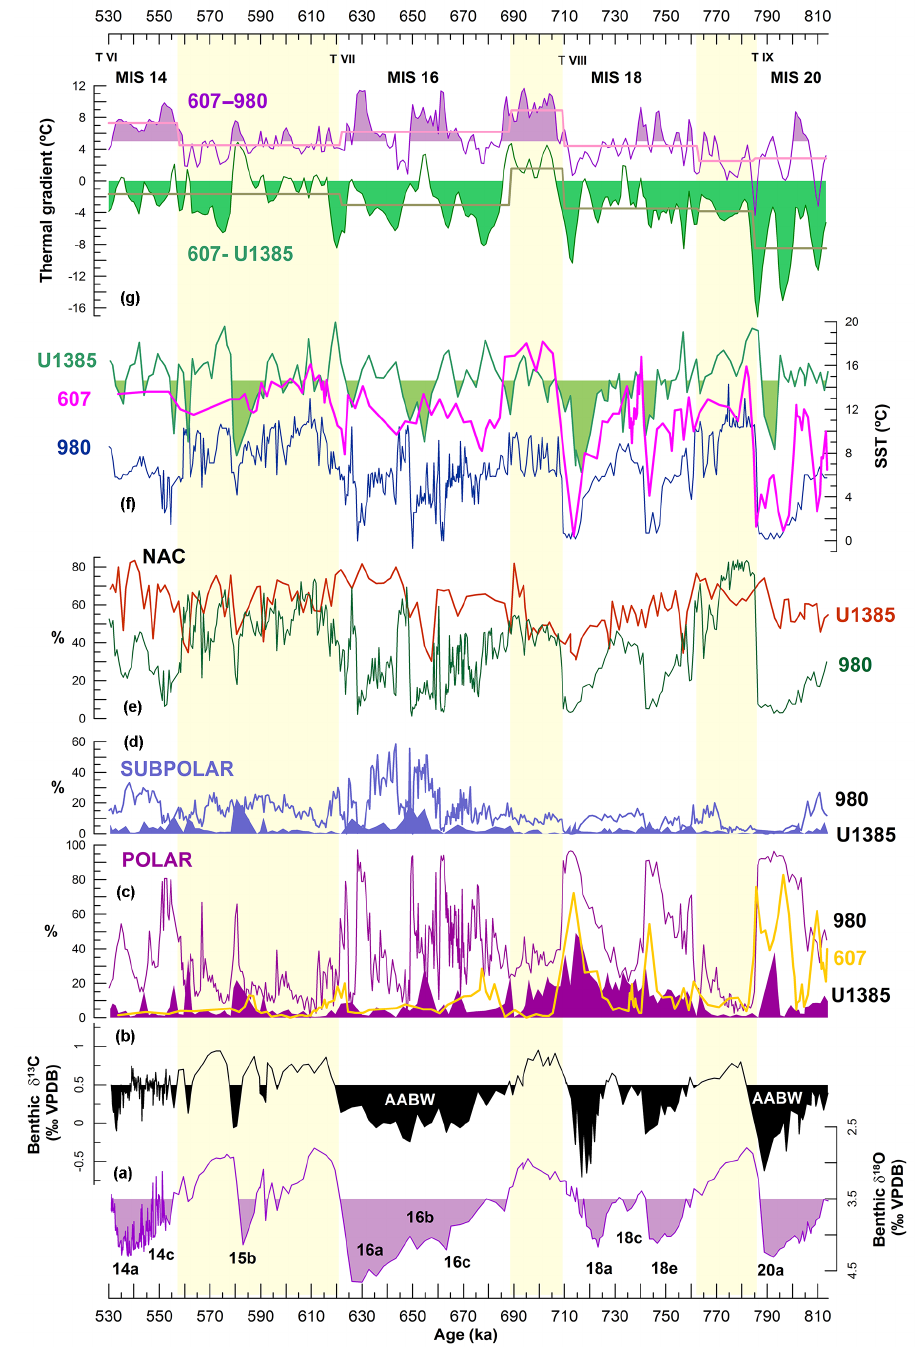
Figure 3. Comparison of records from the midlatitude (IODP-U1385; ODP-607) and the subpolar (ODP-980) North Atlantic. Benthic δ 18 O (a) and δ 13 C (b) from U1385 (Hodell et al., 2015); filling in panel (b) is enhancing 13 C-depleted values typical for Antarctic Bottom Water (AABW) (Adkins et al., 2005). (c) Percentage of N. pachyderma sinistral at sites U1385 (filled), 607 (glod), and 980 (purple). (d) Relative abundance of T. quinqueloba for sites U1385 (filled) and 980. (e) Relative abundance of the NAC assemblage (as defined by Ottens, 1991) at sites U1385 (red) and 980 (green). Site 980 faunal data are from Wright and Flower (2002); for this work, the NAC assemblage of site 980 has been calculated using the published census counts. (f) SST from sites 980 (dark blue; Wright and Flower, 2002), 607 (pink; Ruddiman et al., 1989), and U1385 (green; Martin-Garcia et al., 2015), with filling enhancing lower temperatures than 14.6 ◦ C, the average SST for the study interval. (g) Longitudinal (green) and latitudinal (purple) thermal gradients, with the statistical mean for each MIS represented in superimposed straight lines. Age models for sites 980 and 607 have been recalculated using the LR04 stock. Yellow bands highlight interglacials. Terminations (T) are marked in Roman